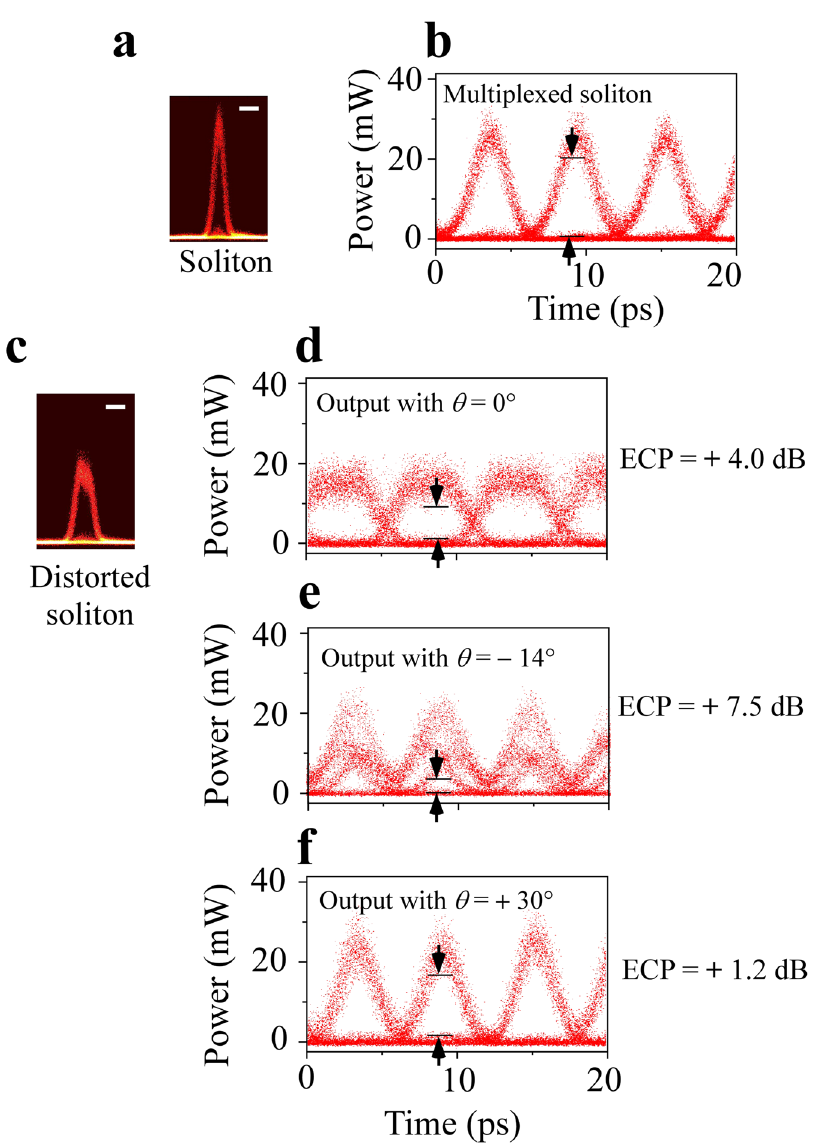
Figure 5. Rectification of a distorted soliton. Eye diagrams for a 160 Gbit/s telecommunication signal at a wavelength of 1550 nm, measured with the forked fibre detector and an optical sampling oscilloscope. (a) Picture of a TE polarized soliton entering the waveguide (scale bar, 5 × 10 − 12 s). (b) Multiplexed soliton. (c) Picture of a distorted soliton. ( d ), (e) , (f) Multiplexed signals corresponding to the distorted soliton at the output of the waveguide for different orientations of the finish line of the forked detector: (d) θ = 0°, (e) θ = − 14°, the eye closure penalty is increased, (f ) θ = + 30°, the eye closure penalty is almost